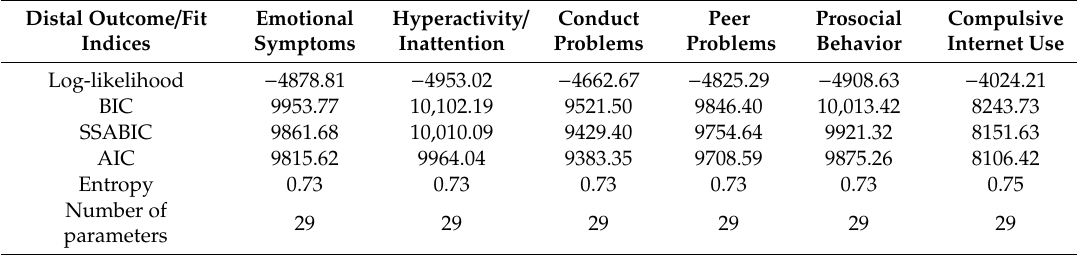
Table 6. The fit indices for the mixture